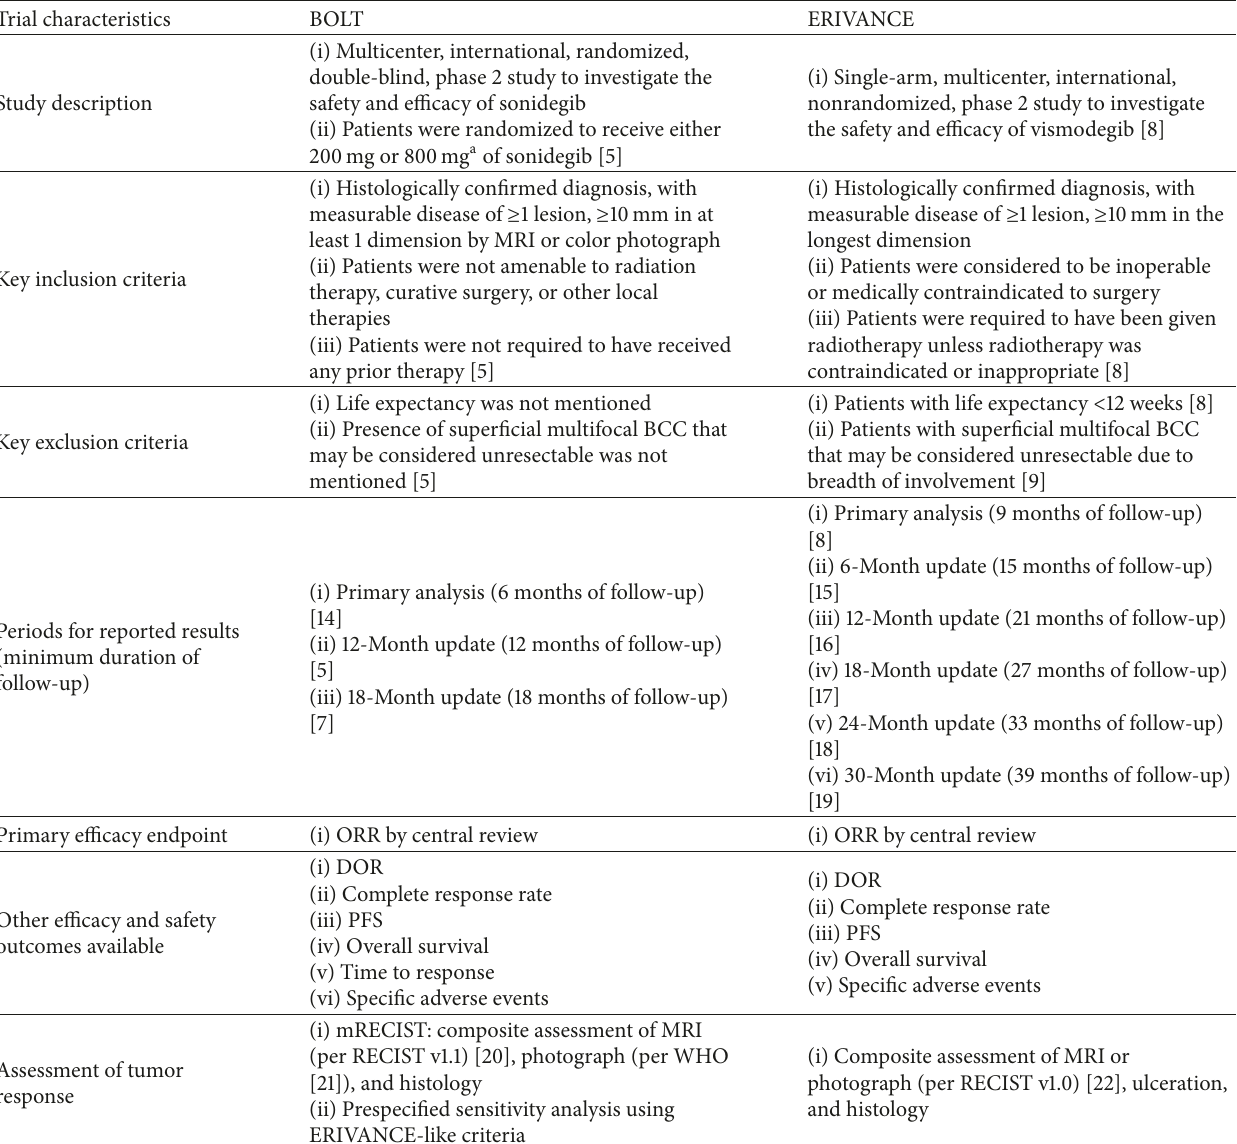
Table 1: Overview of trial designs, including outcome